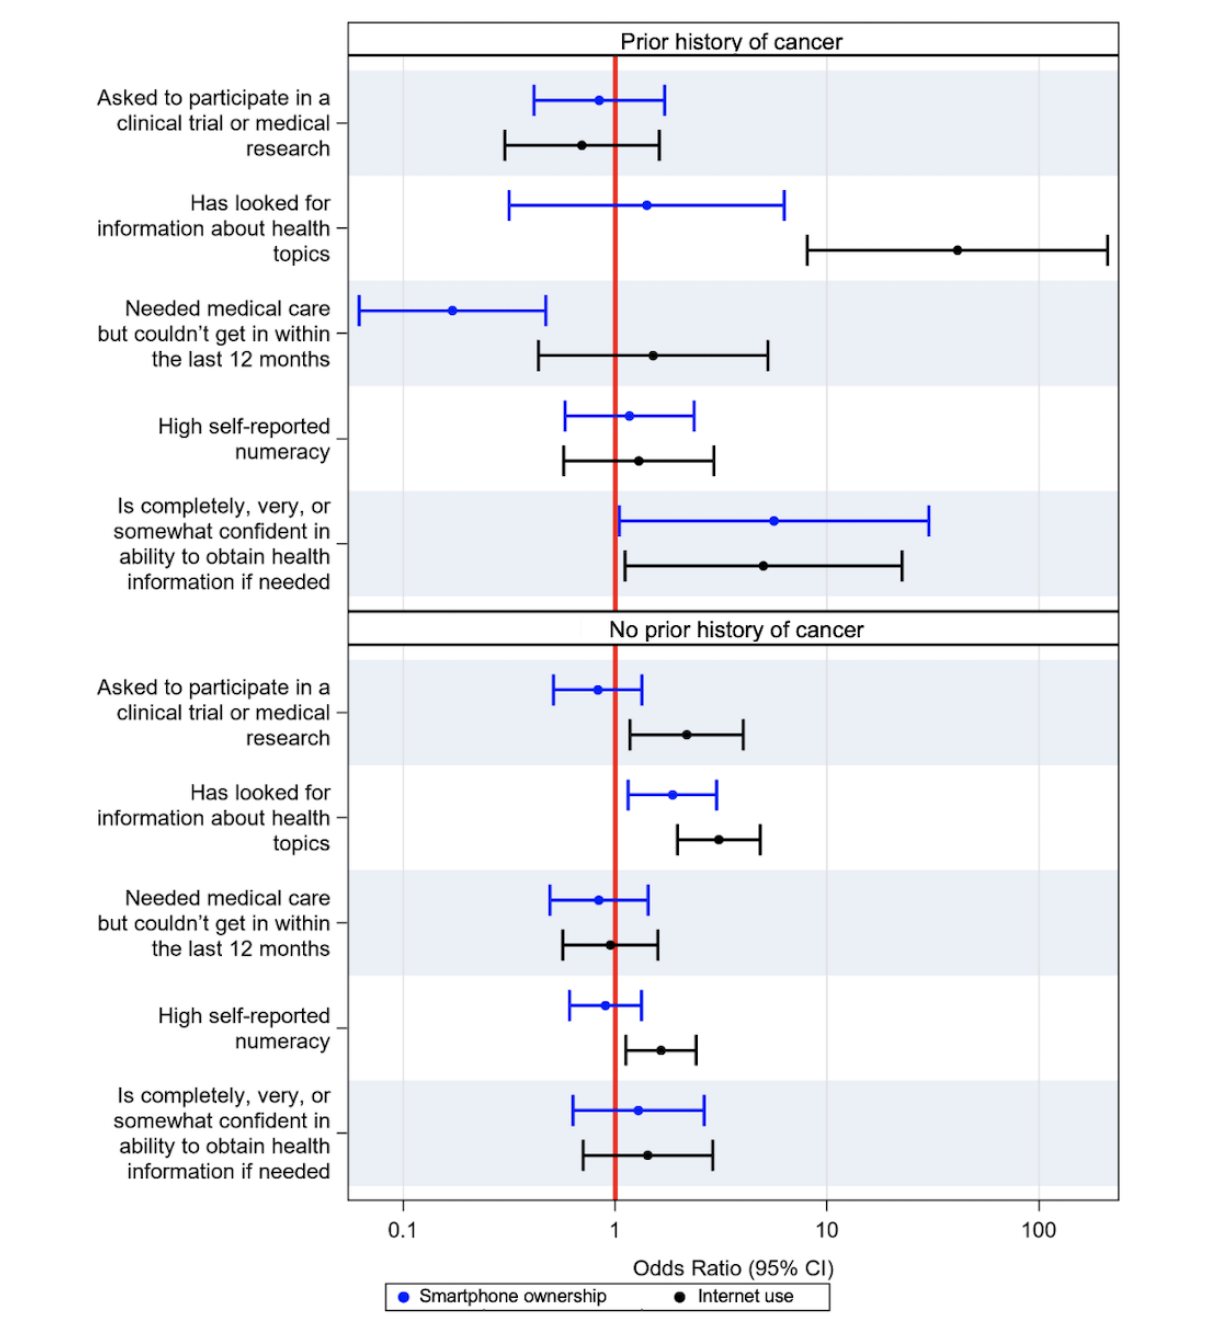
Figure 5. Association of smartphone ownership and internet use with markers of health literacy and health access in participants with (top) and without (bottom) a prior history of cancer. Separate models were used for each outcome listed on the left, with smartphone ownership or internet use included as a